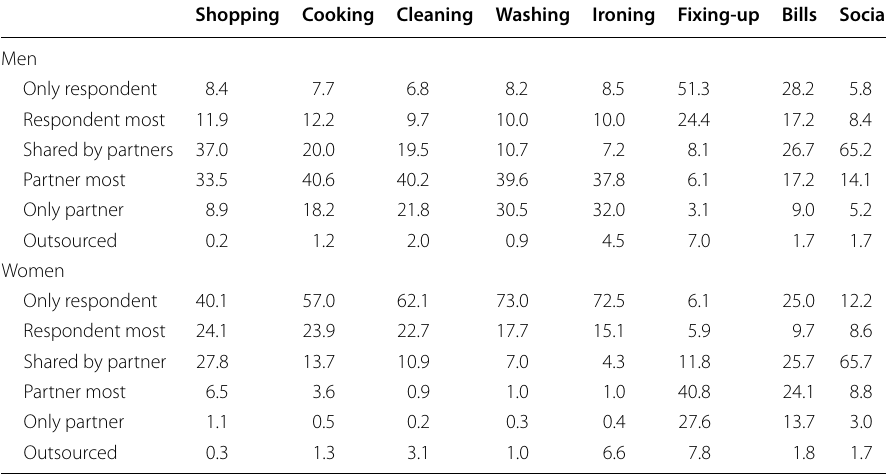
Table 4 Descriptive statistics of housework